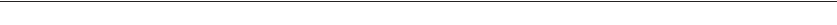
FIGURE1(Continued) of E GABA of layer V pyramidal neurons from the mPFC at P 21. WT (black open circles) and WNK3 KO (red open circles) indicate individual data points. The mean values are indicated with solid bars next to the data points (WT = − 61.95 ± 1.16mV, n = 11 cells, 6 mice; WNK3 KO = − 55.70